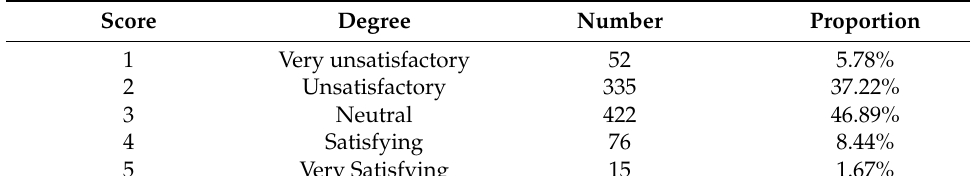
Table 1. The Proportion of Streetscape Images at Five Levels.